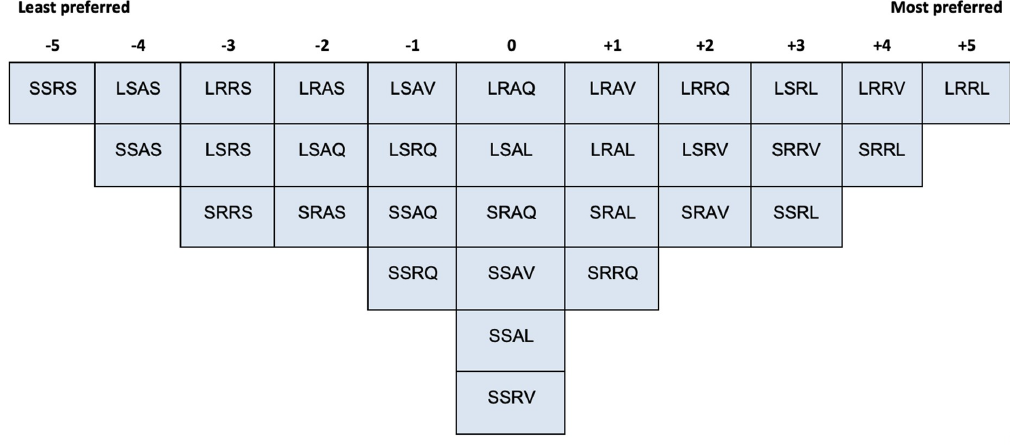
Figure 8. The shared Q-sorting result of participants loaded on Q-factor 2.